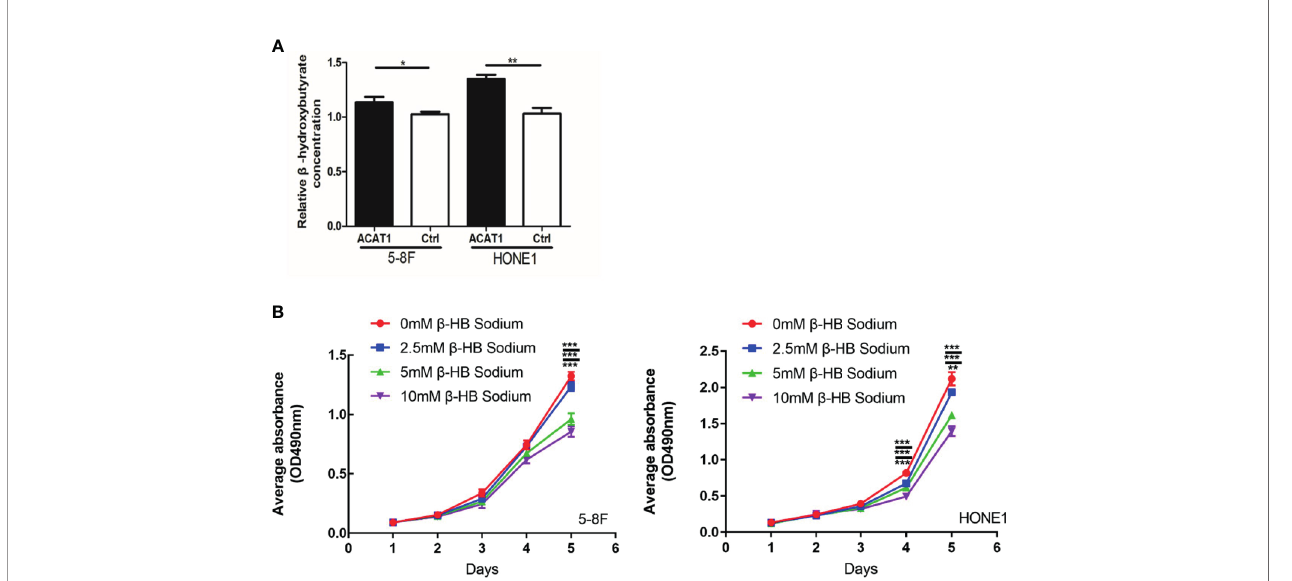
FIGURE 7 | ACAT1 elevates the intracellular level of b -hydroxybutyrate ( b -HB) inNPC cells. (A) The relative concentration of intracellular b -HB in ACAT1-5-8F/HONE1 and Ctrl-5-8F/HONE1 cells. (B) MTT assay was performed to measure theproliferation of 5-8Fand HONE1 cells after b -HB treatment at 0 mM, 2.5 mM, 5 mM, and 10 mM. The independent Student ’ s t-test was used to analyze the results and data are expressed as the means± SD(n=5). * p < 0.05; ** p < 0.01; *** p <